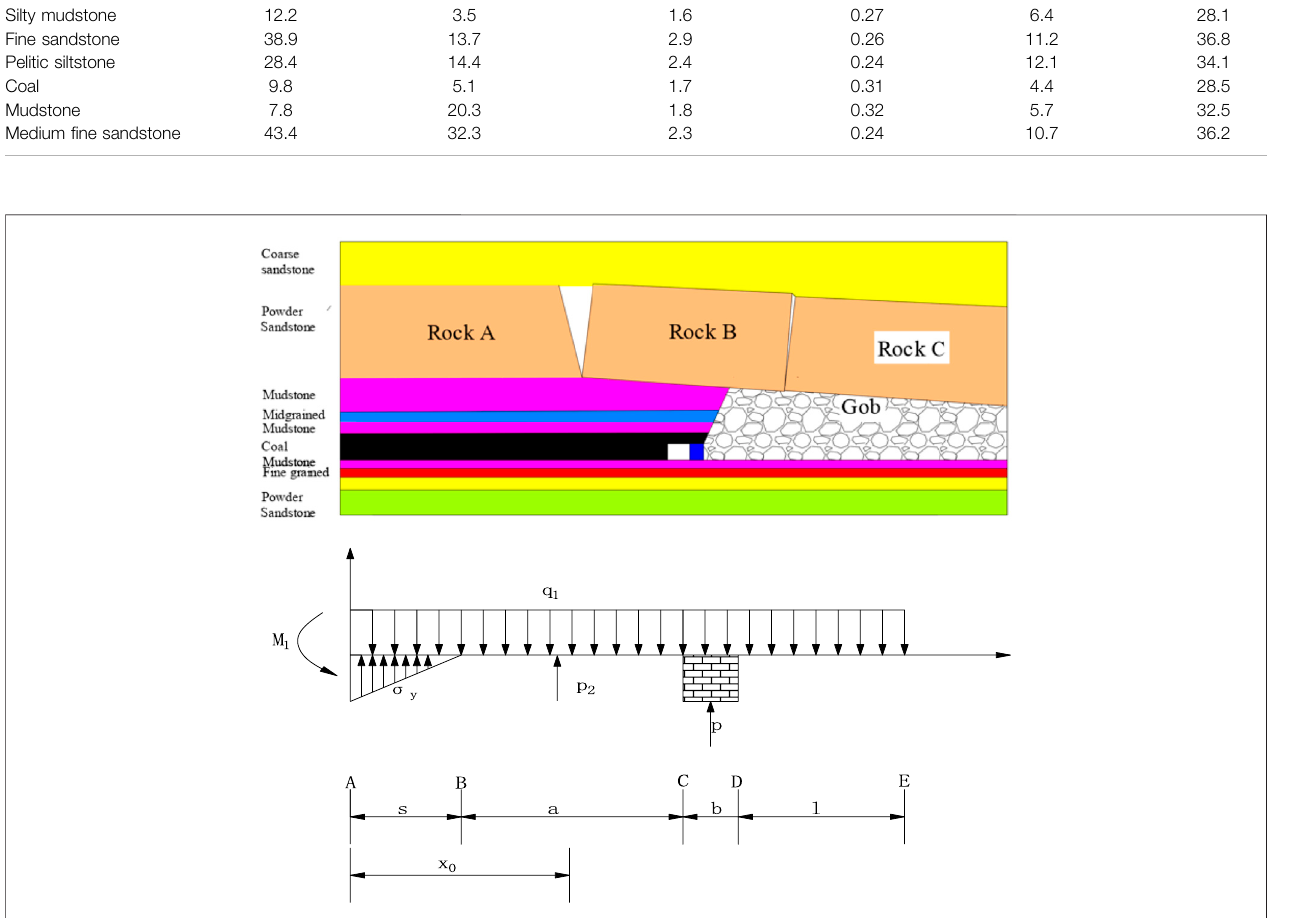
FIGURE 6 | Simpli fi ed physical model of a lateral cantilever beam.